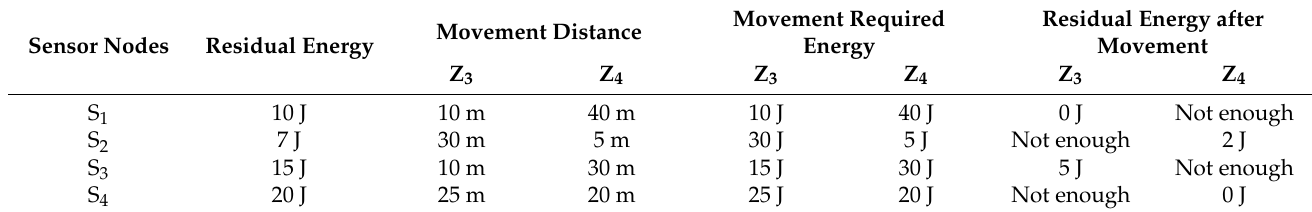
Figure 6. Initial deployment before the movement operation. Table 3. Parameters of mobile sensor nodes. Three combinations of the proposed optimal solution parameters are selected, listed